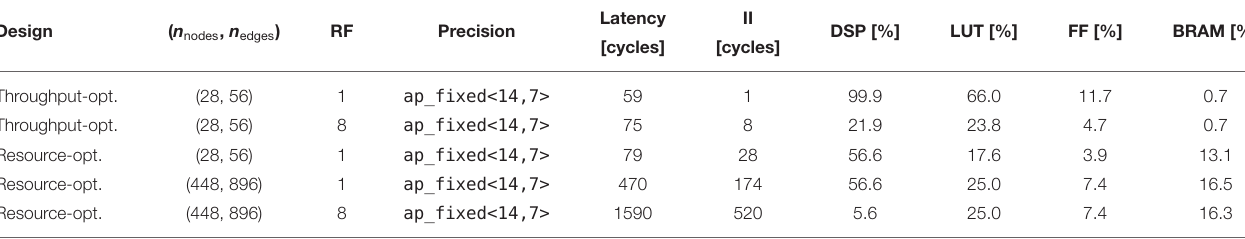
TABLE 1 | Summary of the latency, II, and FPGA resource usage metrics of the synthesized firmware for a variety of design choices.